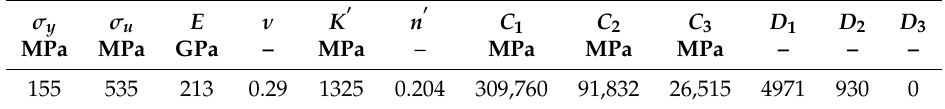
Table 1. Mechanical properties of S355J2 steel.